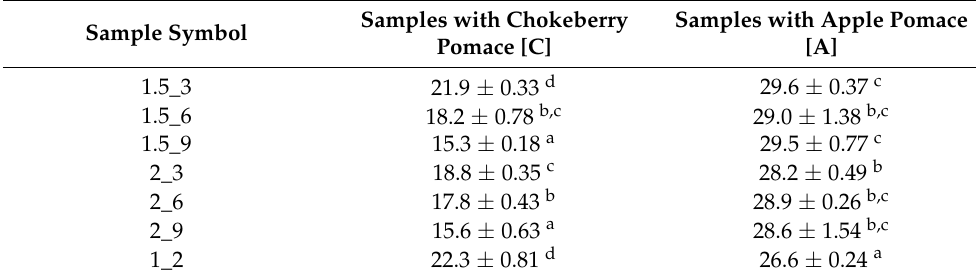
Table 3. Colour saturation index [SI] of freeze-dried fruit bars. Mean values marked with the same index letter (a–d) do not differ statistically significantly at the level of p = 0.05. Denotations in Table 1 include Index (A) next to the sample symbol—bars with the apple pomace, Index (C) next to the sample symbol—bars with the chokeberry